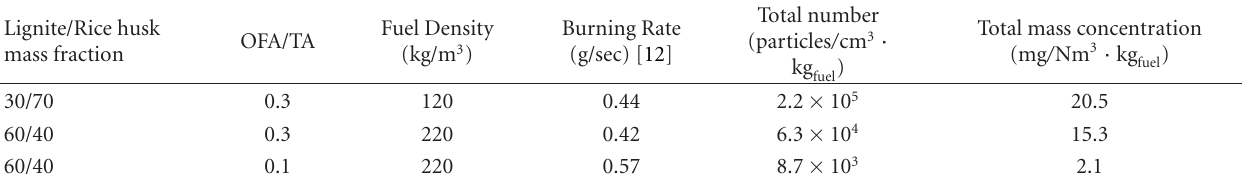
Table 3: Total number/mass concentration of